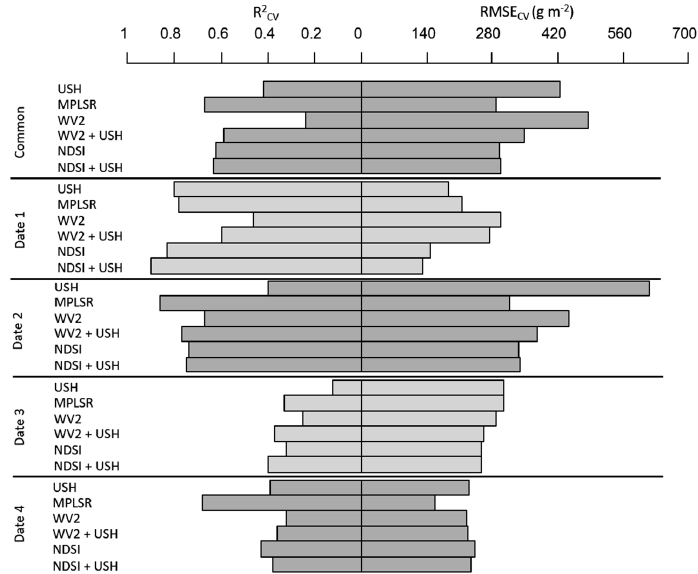
Figure 2. Cross-validation (CV) results for a range of sensor models used for prediction of dry matter yield (DMY), including exclusive use of ultra-sonic sward height (USH), all hyperspectral wavebands using modified partial least squares regression (MPLSR), normalized difference spectral index (NDSI), and multispectral representation of WorldView-2 wavebands (WV2), as well as models formed from combinations of these sensors.